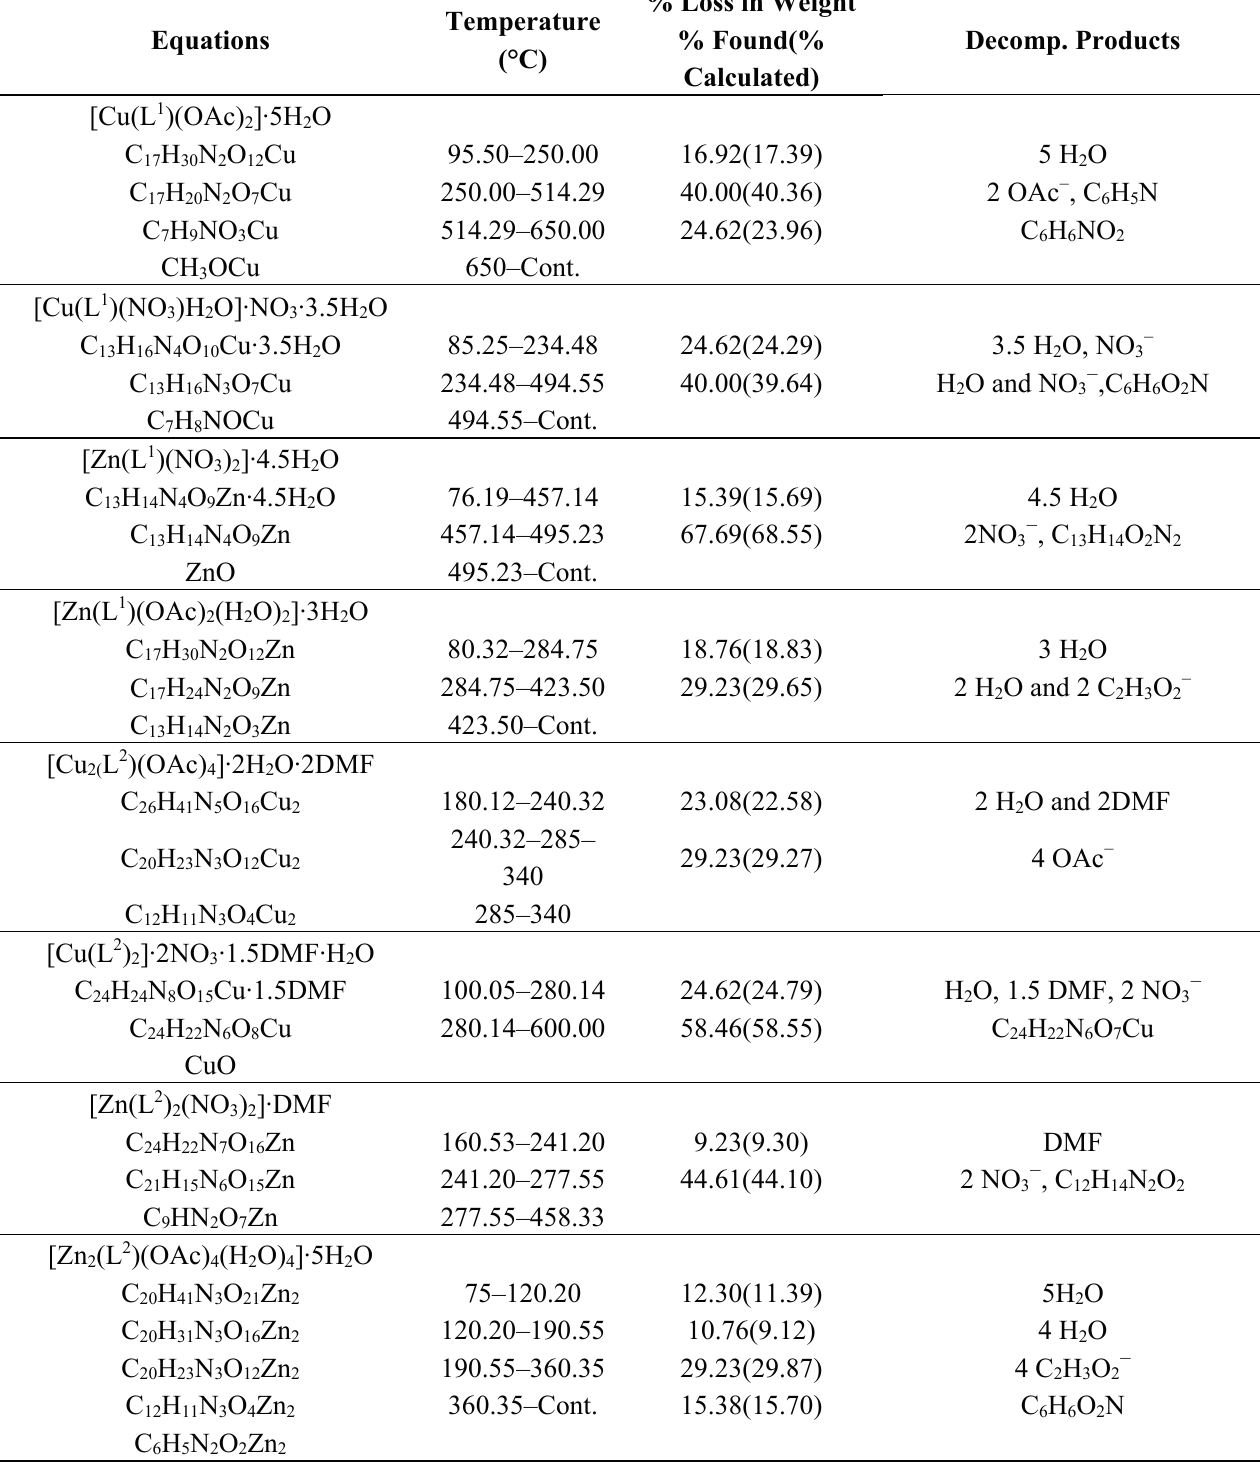
Table 1. Proposed decomposition steps and the respective mass losses of ligands (L 1 and L 2 ) and their